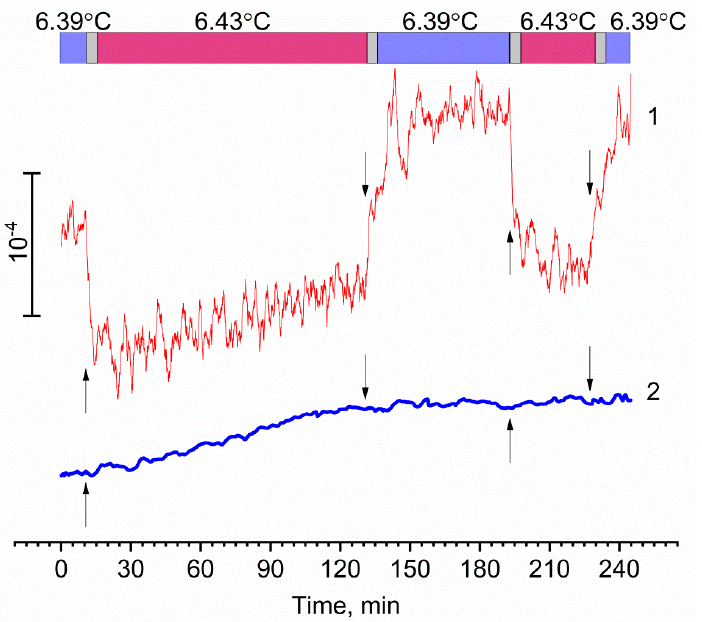
Figure 7. Photoinduced changes of the relative velocity of ultrasound in the suspension containing photosystem II core complexes with the removal of the water-oxidizing complex. The kinetics are presented before (1) and after (2) temperature compensation. The panel at the top of the figure shows the change of temperature in the cells induced by illumination. ↑ and ↓ represent the steady-state actinic light ( λ = 400 nm–800 nm, 1500 μ mol photon s − 1 m − 2 ) being on and off, respec-